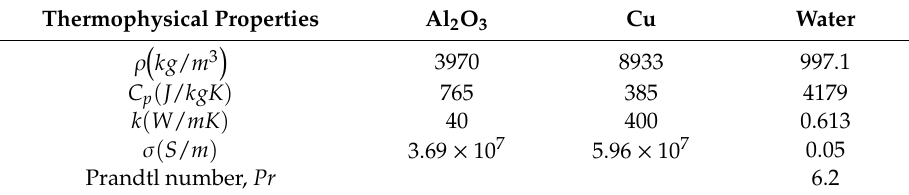
Table 2. Thermophysical properties of Al 2 O 3 , Cu, and